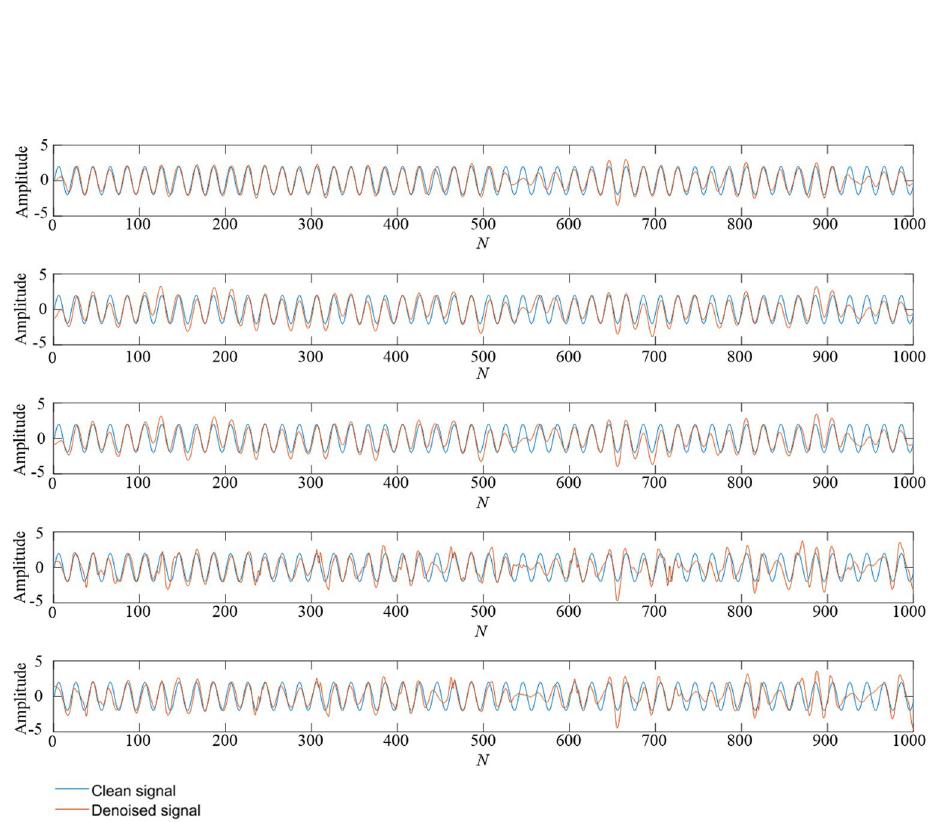
Figure 6. A comparison of denoising effect under -10 dB. From top to bottom: ( 1 ) TS-WOA-VMD-CA-WT; ( 2 ) WOA-VMD-CA-WT; ( 3 ) TS-VMD-CA-WT; ( 4 ) EMD-CA-WT; ( 5 )